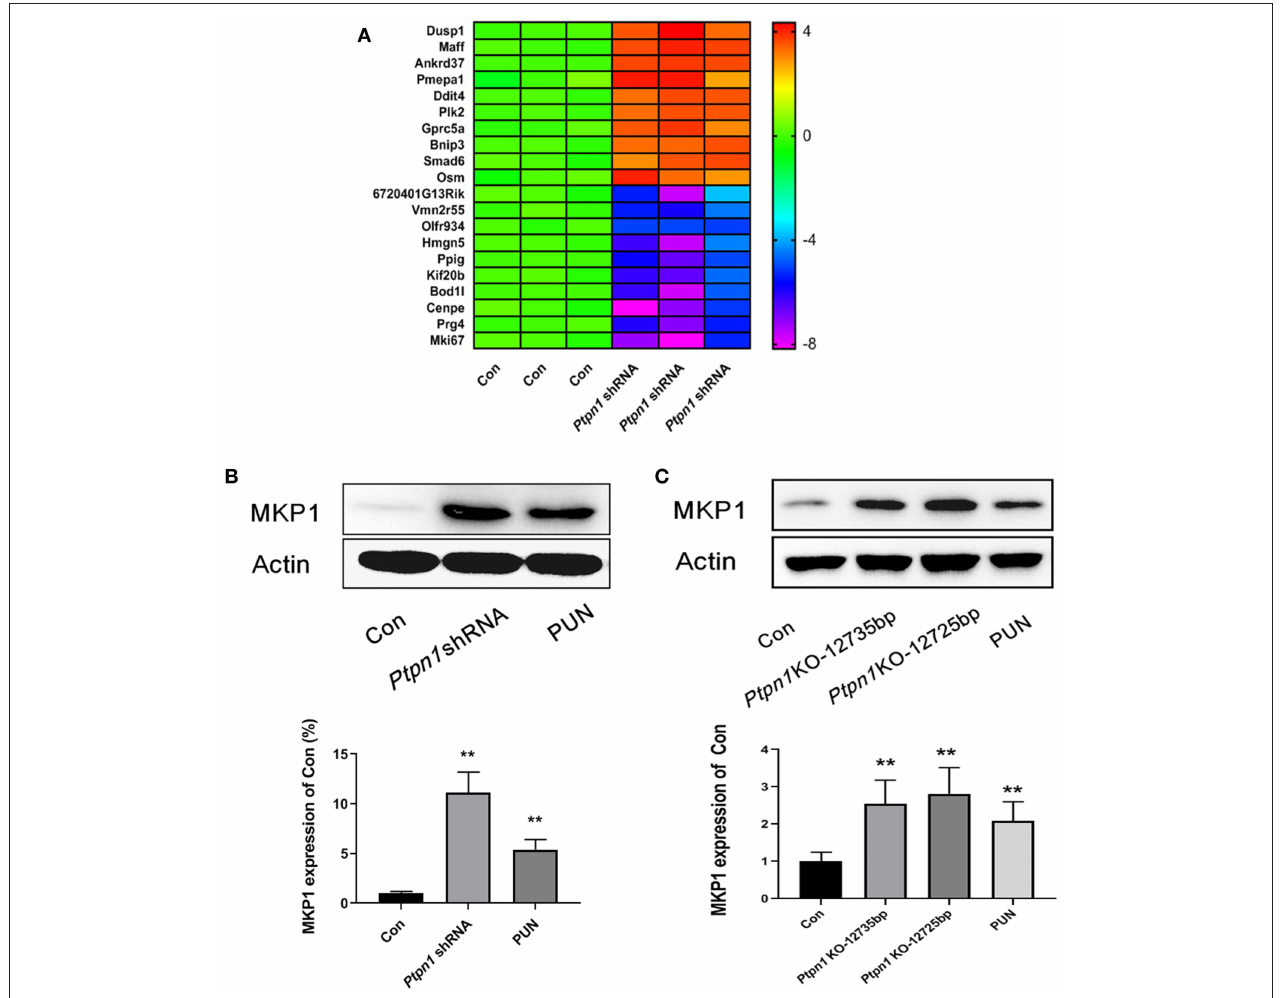
FIGURE 1 | Inhibition of PTP1B leads to upregulation of MKP1. (A) Assessment of the downstream genes of PTP1B by transcriptional profiling. Ptpn1 WT cells (Con) and knockdown cells were incubated for 24h and harvested for transcriptional profiling analysis. Three independent experiments were performed and the fold changes (in log2 value) in the control group were found, which are presented in the heatmap. (B) Detection of the MKP1 expression in RAW264.7 cells. The cells of the control and Ptpn1 knockdown groups were incubated for 24h without specific treatment. For the PUN treatment group, Ptpn1 WT cells were incubated with 20 µ M PUN for 24h. (C) Detection of the MKP1 expression in peritoneal macrophages. Peritoneal macrophages were obtained from indicated mice groups, including Ptpn1 WT and Ptpn1 knockout mice of two sequences. Ptpn1 WT cells incubated with 20 µ M PUN for 24h were represented as PUN group. Data are expressed as mean ± SD of three independent experiments. ** p < 0.01 indicates statistically significant difference compared with control